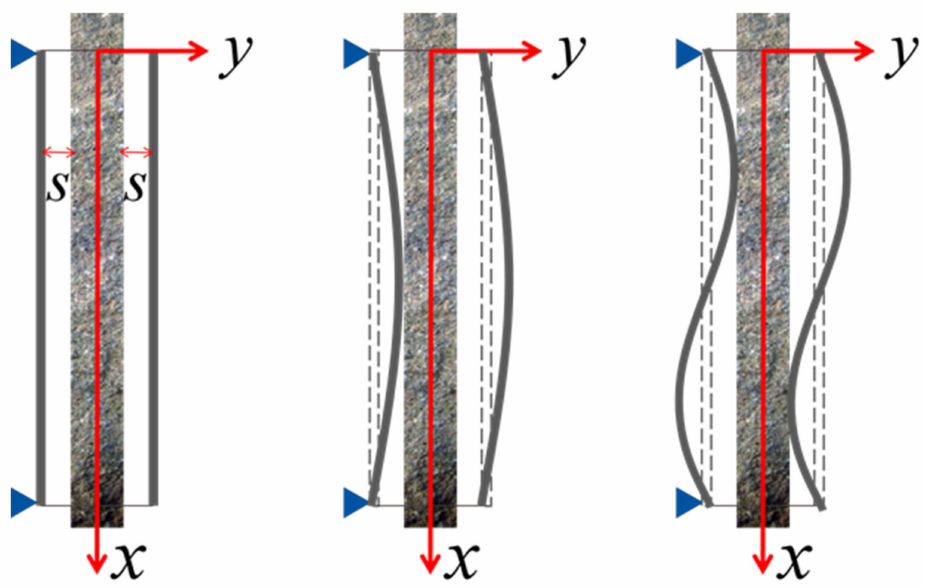
Figure 3. Several forms of contact between coring drillpipe and core.